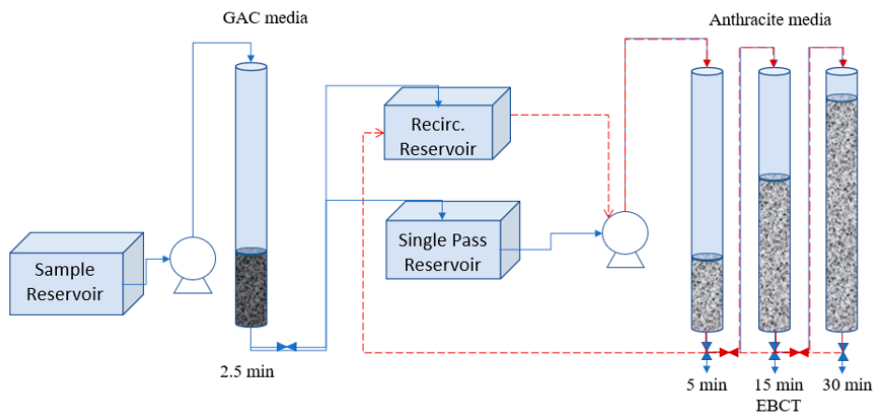
Figure 1. Bench-scale granular activated carbon filter followed by an anthracite biofilter (operated in three-column series) via recirculating batch reactor method (dotted red line) and single-pass flow- through method (solid blue line) as detailed in Terry et al., 2019. GAC, granular activated carbon; EBCT, empty bed contact time; recirc., recirculating .